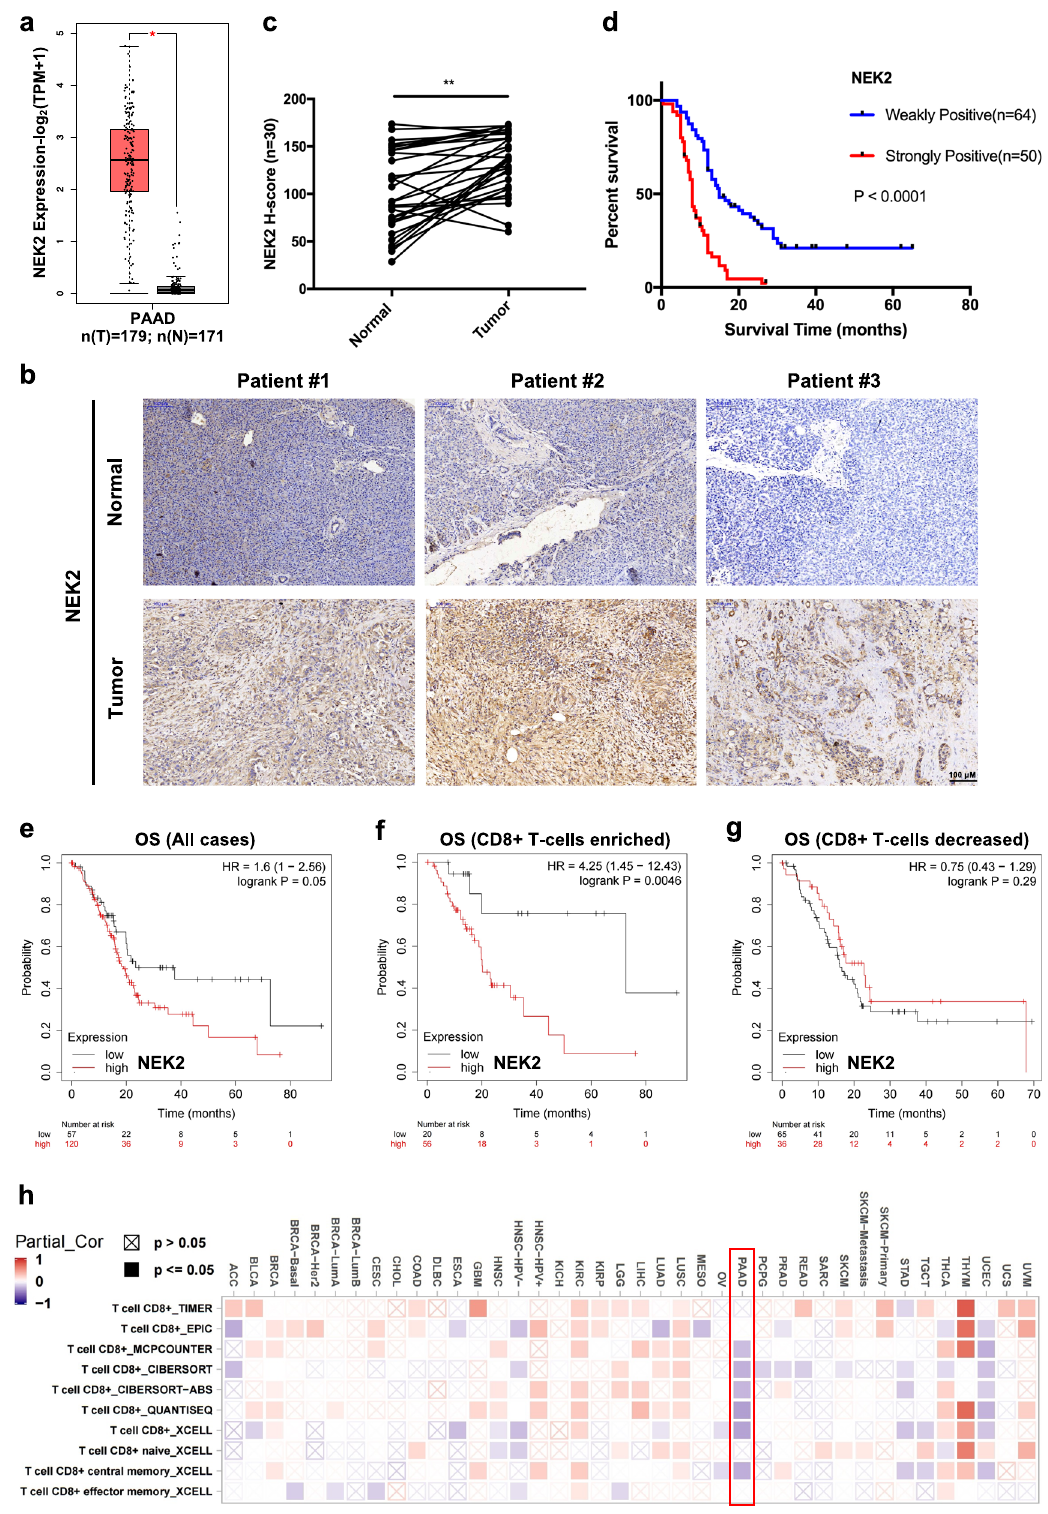
cells, NEK2 KD-cells displayed signi fi cantly weakened resistance to T cell-mediated tumor cell-destruction in vitro (Supplementary Fig. 5a, b). The growth of NEK2 KD cell-derived tumors was consistently signi fi cantly repressed in immunocompetent C57BL/ 6 mice but not in immunode fi cient nude mice (Fig. 2a – h). Flow cytometry further revealed a signi fi cant increase in the number and function of CD8 + T cells in NEK2 KD cell-derived tumors